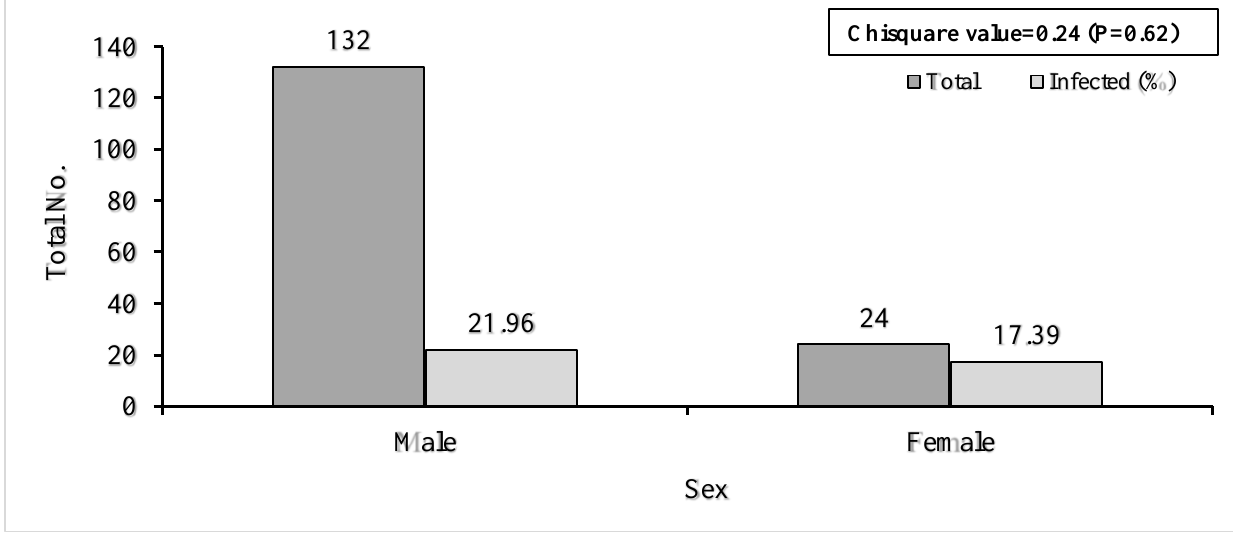
Figure 2. Infected rate of Trypanosoma evansi in camels according to sex, n= 132 for males, n=23 for